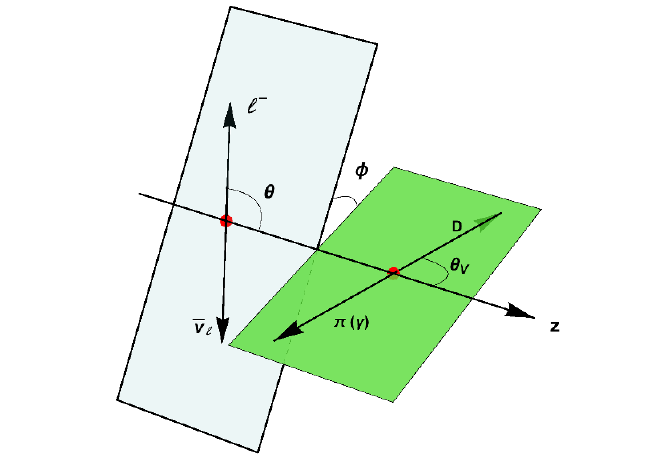
Figure 1 . Kinematics of (cid:22) B ! D (cid:3) ( ! DF ) ‘ (cid:0) (cid:22) (cid:23) ‘